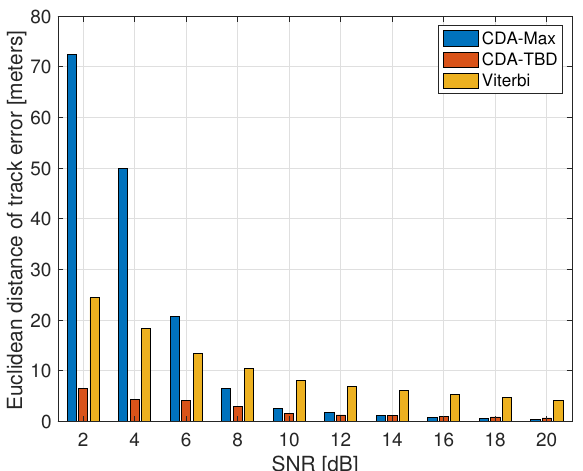
Figure 9. Average tracking error for the three detection approaches as a function of the SCR. Results show resilience of CDA-TBD to high